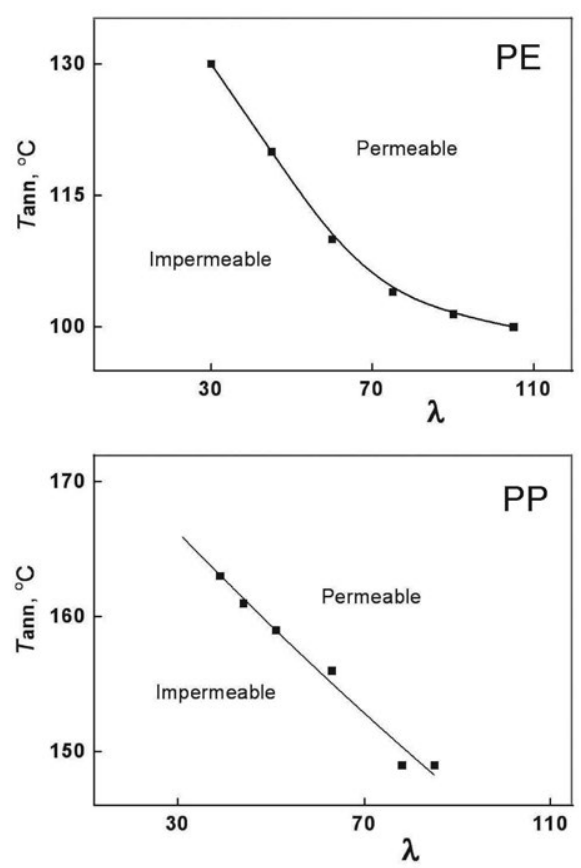
Figure 4. Relation between λ and T overall porosity for PE and PP films. Uniaxial extension is